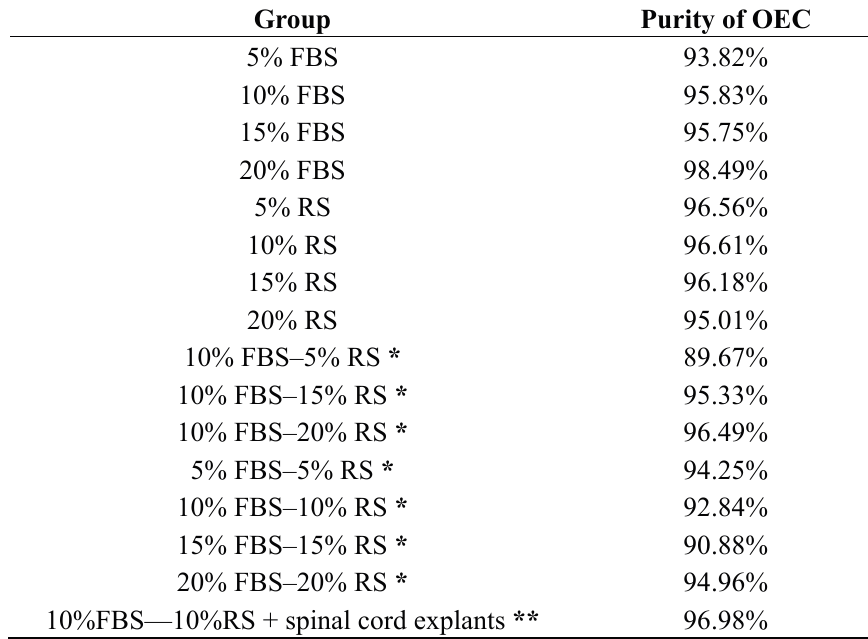
Table 1. OEC purity in each